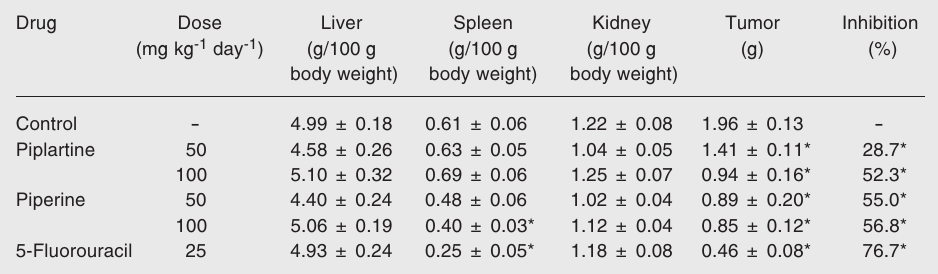
Table 1. Effect of piplartine and piperine on Sarcoma 180 tumors transplanted in